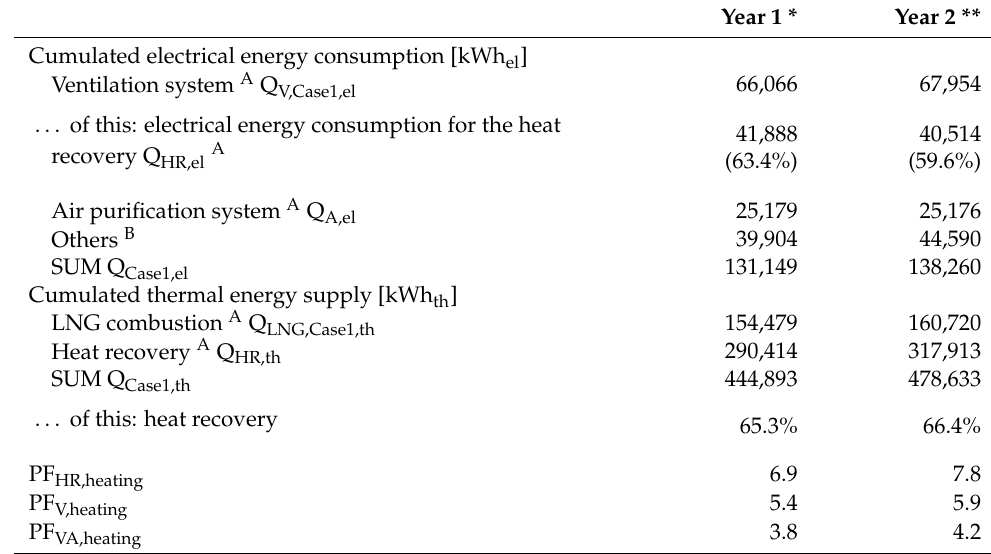
Figure 6. Dependency of the effectiveness ( ε ) of the two heat exchangers and the fresh air tempera- ture [°C] when heat exchangers heated the incoming fresh air. This figure shows 99.4% of the values given, 0.6% (360 of 55,082 measurement intervals) are considered irregular outliers outside the nom- inal range of effectiveness (0–1). Table 2. Cumulated electrical energy consumption [kWh el ], thermal energy supply [kWh th ], and the PFs heating for trial years 1 and